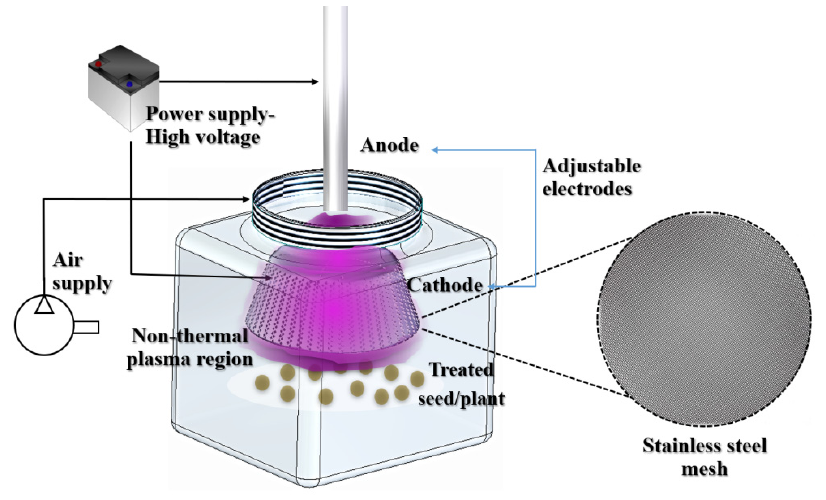
Figure 1. Experimental configuration of NTP plasma reactor.